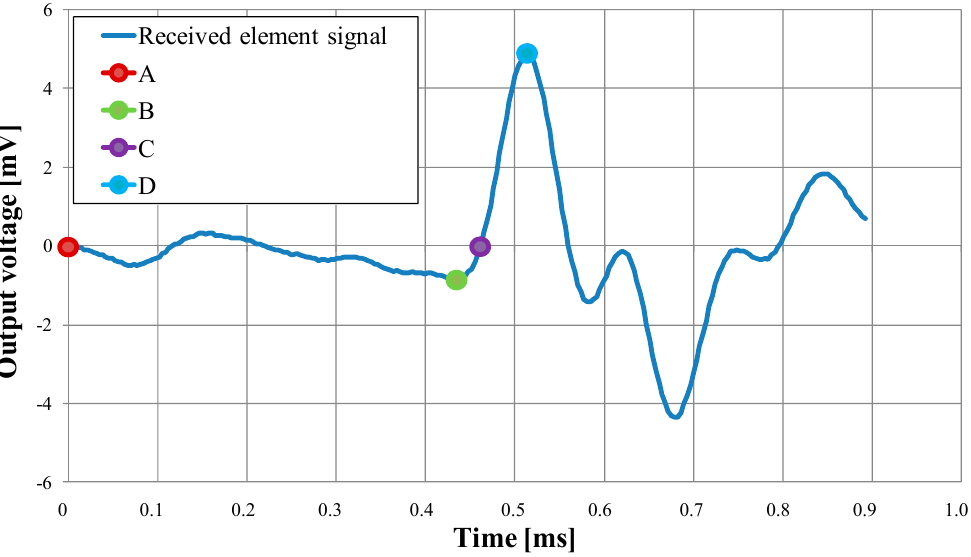
Figure 5. Receiver time charts: A) first deflection; B) first bump; C) zero crossing; D) first major peak. An example of test results from pure RCA specimen No. 2, T = 0.16 ms, p ′ = 90 kPa.